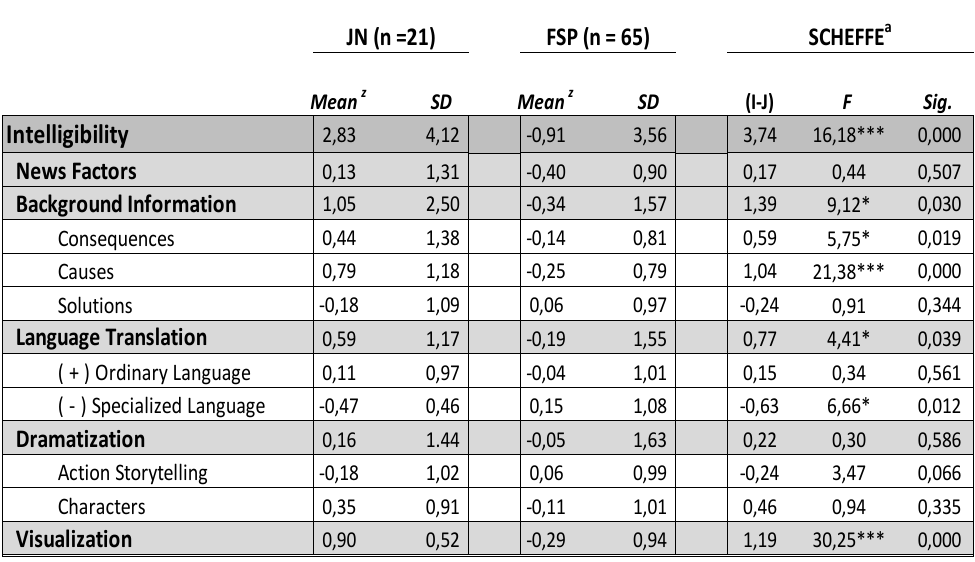
Table 5 . Multiple Comparisons (Scheffé) of Intelligibility in the COP15 Coverage